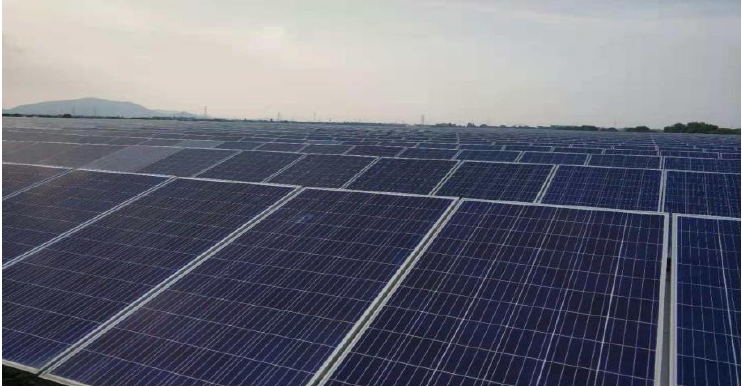
Figure 1. The fishery light complementary large-scale PV power